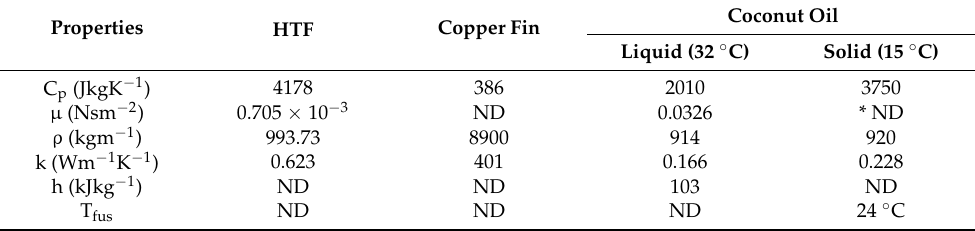
Table 2. The thermophysical properties of five nanoparticles [26–28] .